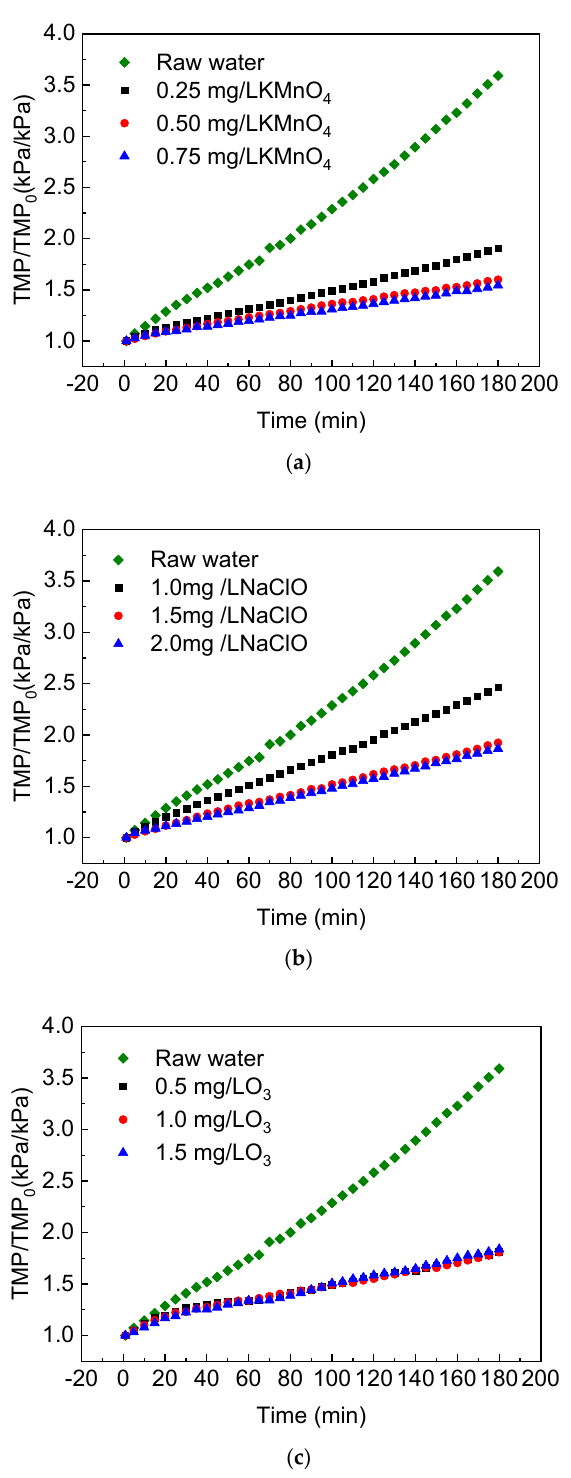
Figure 2. Effect of pre-oxidation on the specific transmembrane pressure of the ceramic membrane: ( a ) KMnO 4 ; ( b ) NaClO; ( c ) O 3 . The ceramic membrane flux was constant at 120 L/(m 2 ∙ h) during this experiment. The computer system recorded the pressure data in the pipeline during a constant flux filtra- tion in real time and plotted the rising curve of the membrane specific transmembrane pressure rate. Three different oxidants, including KMnO 4 , NaClO and O 3 , were used as